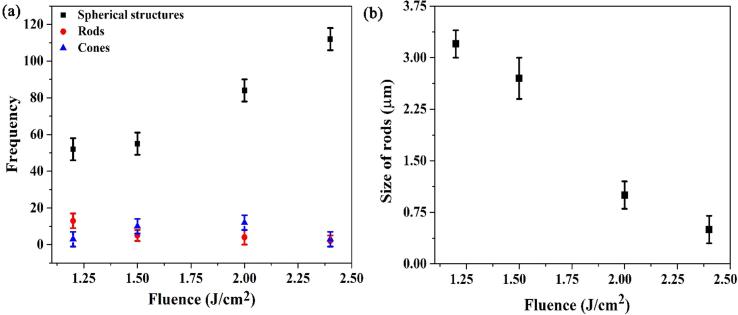
(a) The measured frequency of laser-induced spherical, 1D rods and conic structures shown earlier in Figs. 4(d-f) and Fig. 3(c). (b) The average size of 1D rod structures as a function of laser fluence. The increase in spherical structure frequency as a function of laser fluence corresponds to a decrease in the rod size. This observation indicates that higher fluence lead to fragmentation of the formed rods.